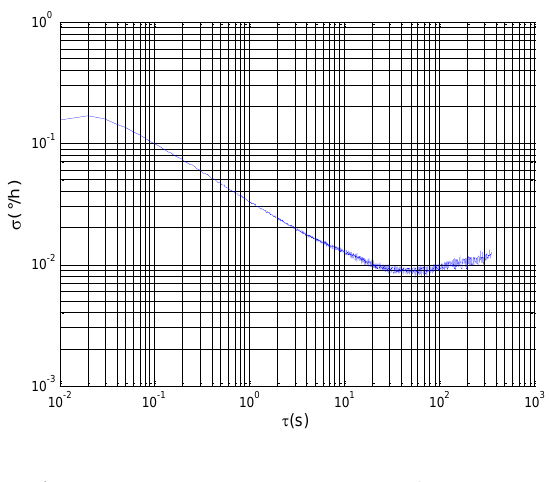
Figure 22. Allan variance plot of #2